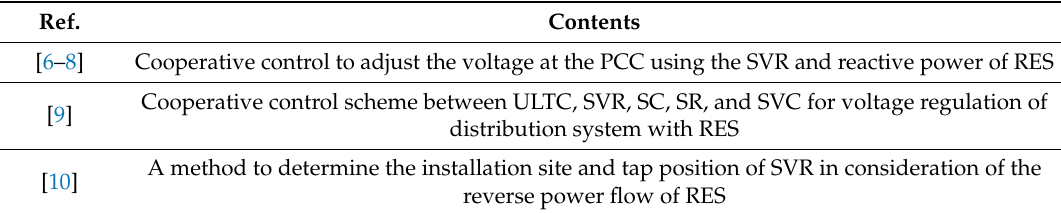
Table 1. Previous researches on voltage control of the distribution system.